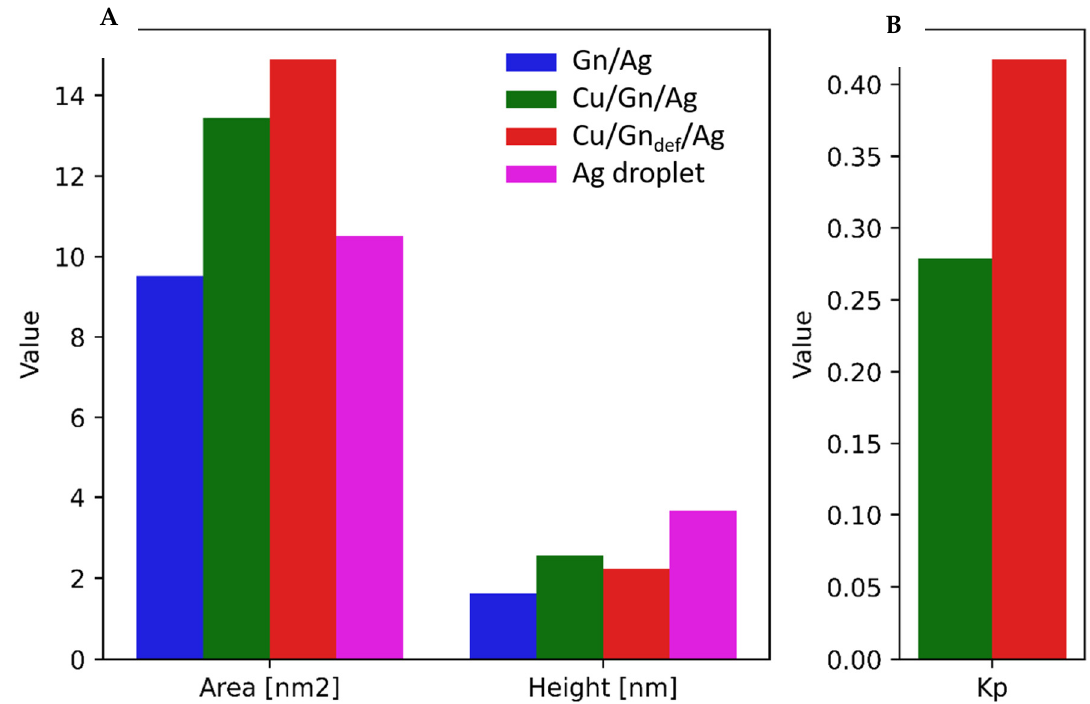
Figure 6 . Wettability test for Cu/Gn and Cu/Gn def substrates at 450 ps. ( A ) The spreading area and the height of Ag droplet on two substrates ( B ) K p spreading coefficient determined for Cu/Gn/Ag and Cu/Gn def substrates and for performed in this work experiment. For a comparison only of spreading area, the results for perfect graphene layer and Ag droplet are also added to part A of figure.